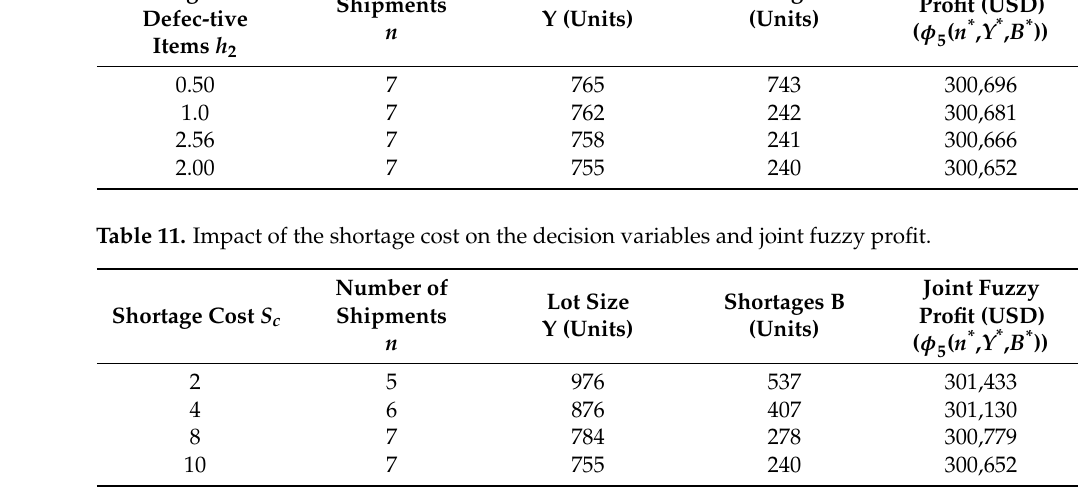
Table 12. Impact of the fixed cost of transportation on the decision variables and joint fuzzy profit.